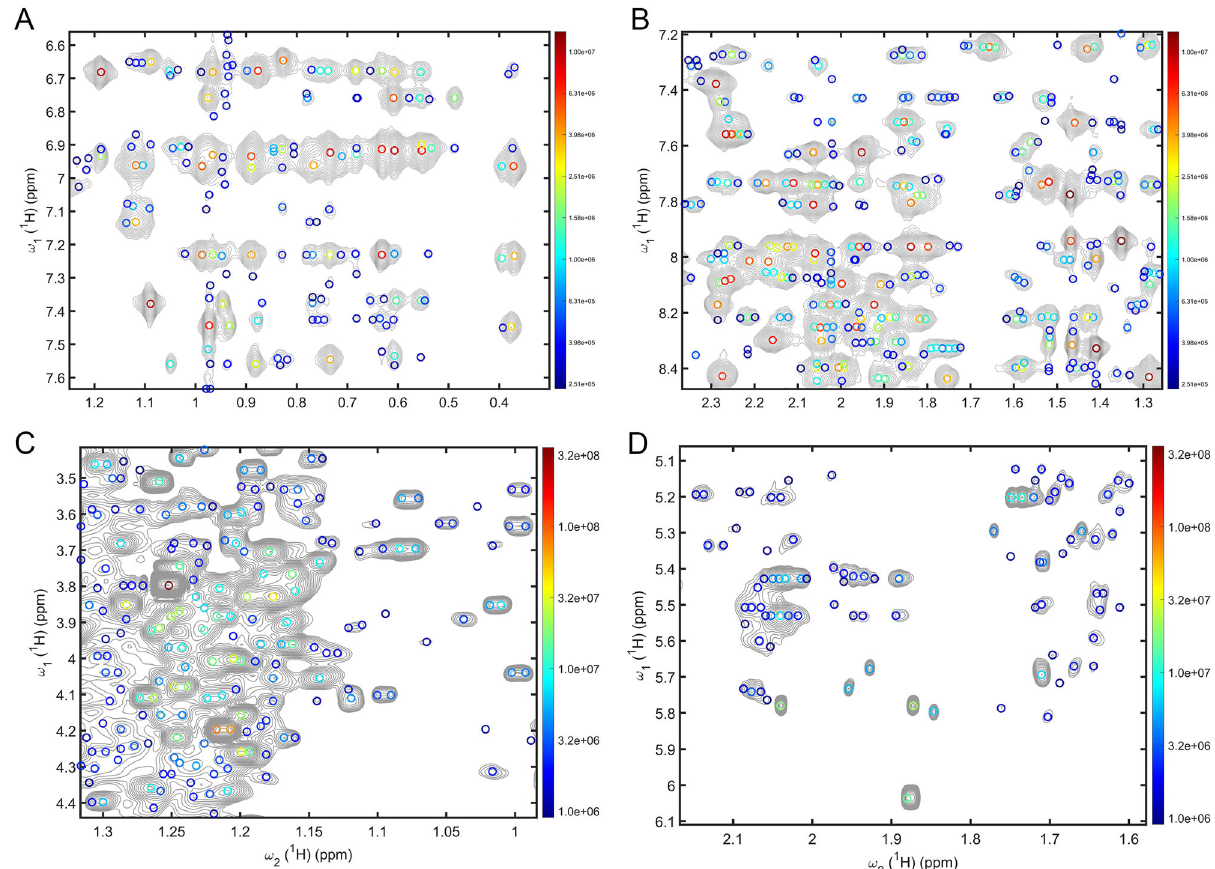
Fig. 8 Application of DEEP Picker to 2D NOESY and TOCSY spectra. A , B Selected regions of 2D 1 H – 1 H NOESY of Im7 and C , D 2D 1 H – 1 H TOCSY of mouse urine with picked cross-peaks indicated as circles that are color-coded according to their amplitude (logarithmic scale, see sidebar). DEEP Picker identi fi es strong and weak cross-peaks, including ones that severely overlap or show multiplet structures due to J-splittings, whose analysis is often challenging for traditional peak